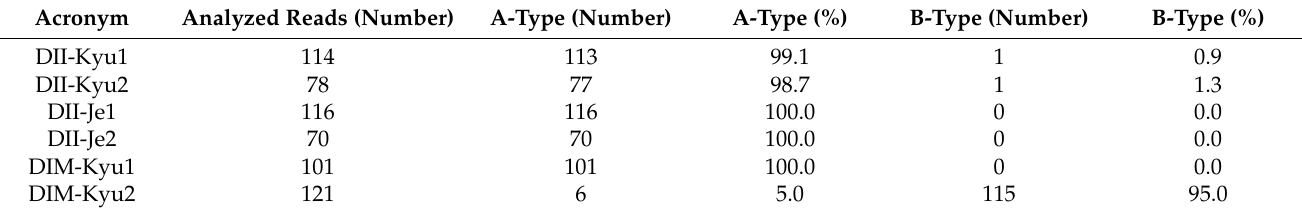
Table 5. Statistics for the alternative mitogenome structure in six individuals of Damnacanthus indicus .